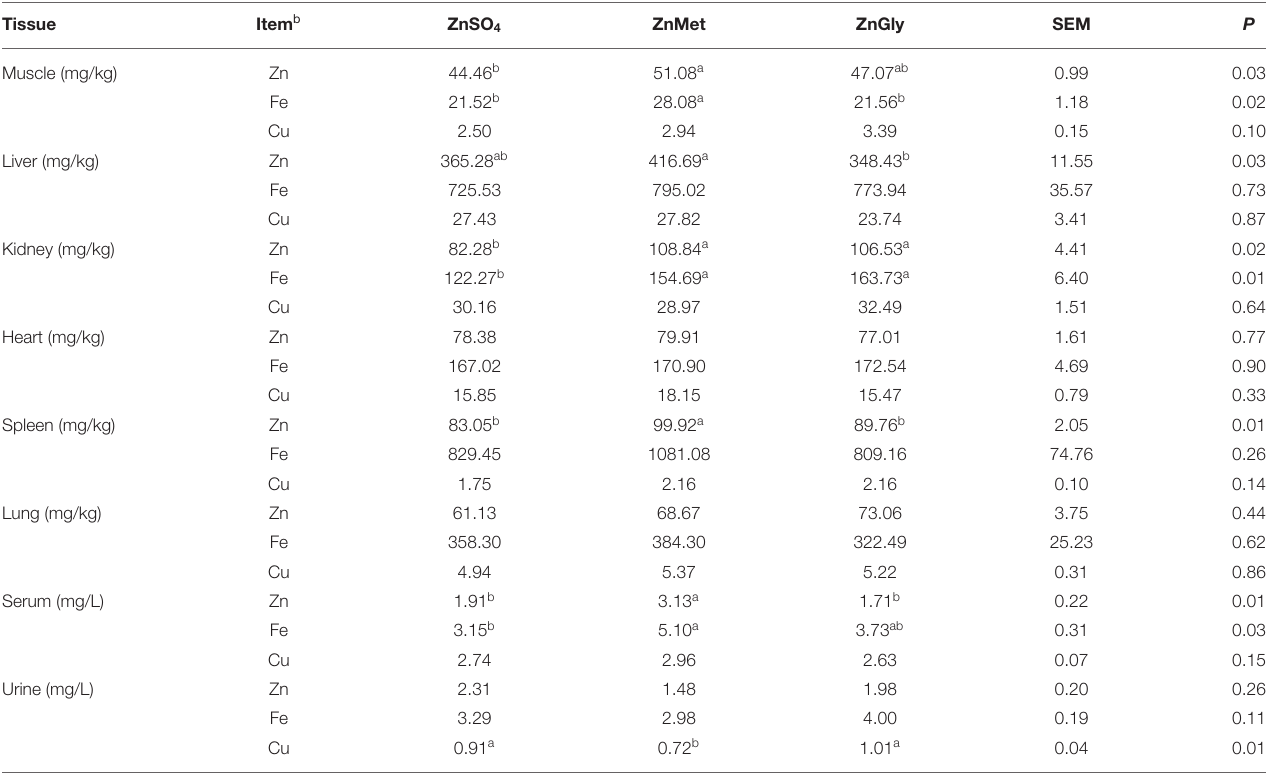
TABLE 5 | Micronutrients content of finishing pigs fed Zn diets a .